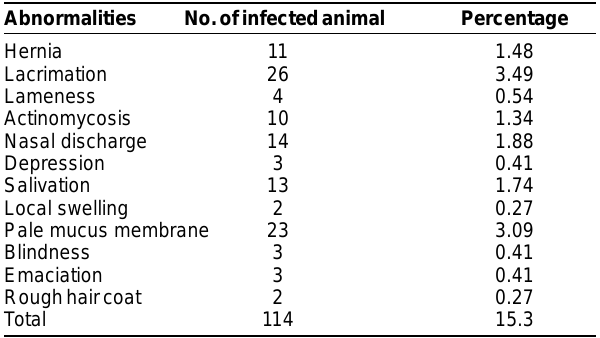
Table-1. Abnormalities encountered during ante mortem to the abattoir for slaughter from different districts examination at Adigrat abattoir